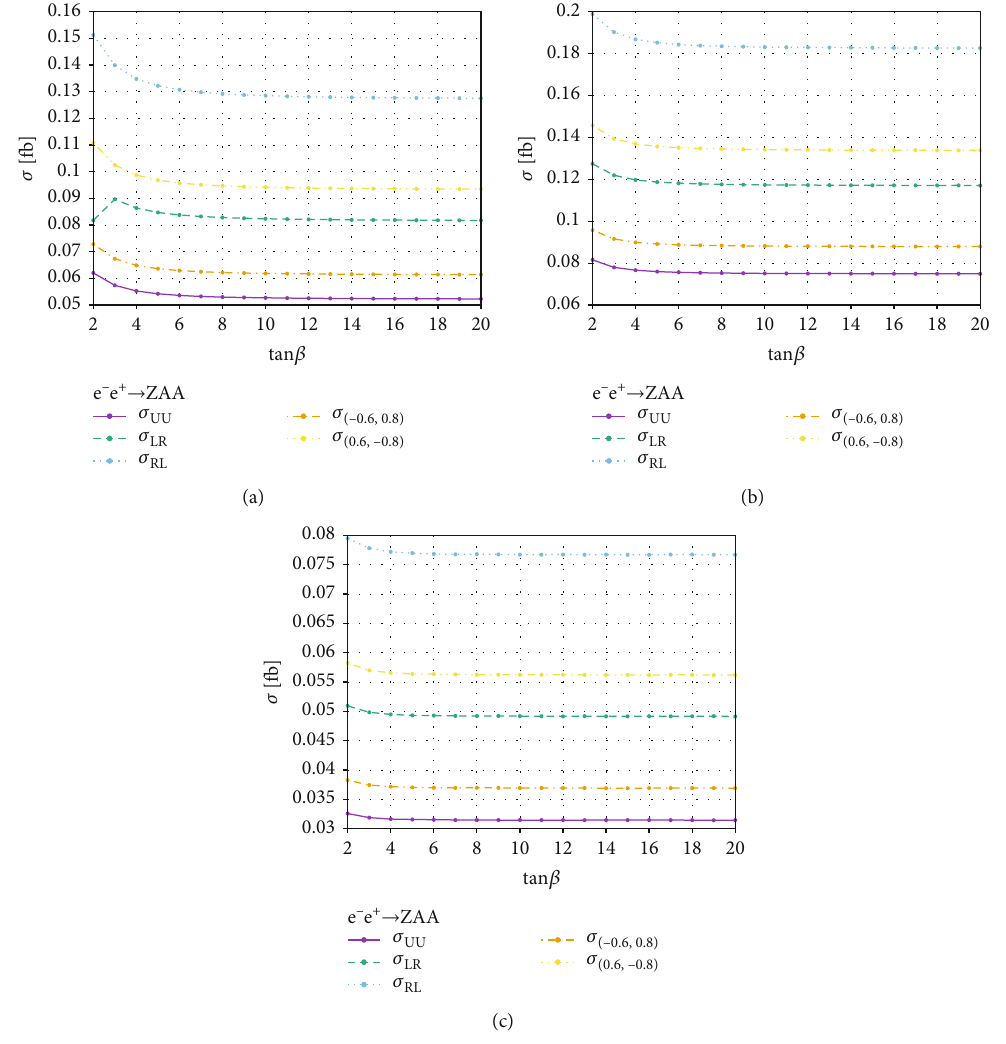
ffiffi p = 0 : 6 TeV, whereas in (b) and (c), same variables are s